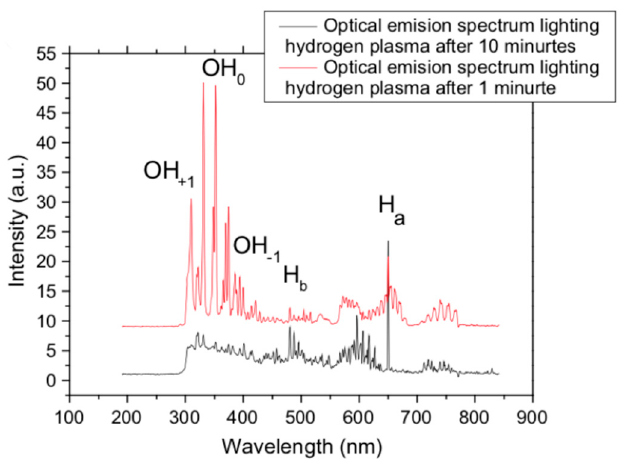
Figure 17. OES of the Cu reduction after 1 and 10 min of the exposure to hydrogen plasma, showing the reduction of the OH peaks that indicates the reduction and removal of the native oxide layer on the surface of Cu substrate (reprinted with permission from [77]).